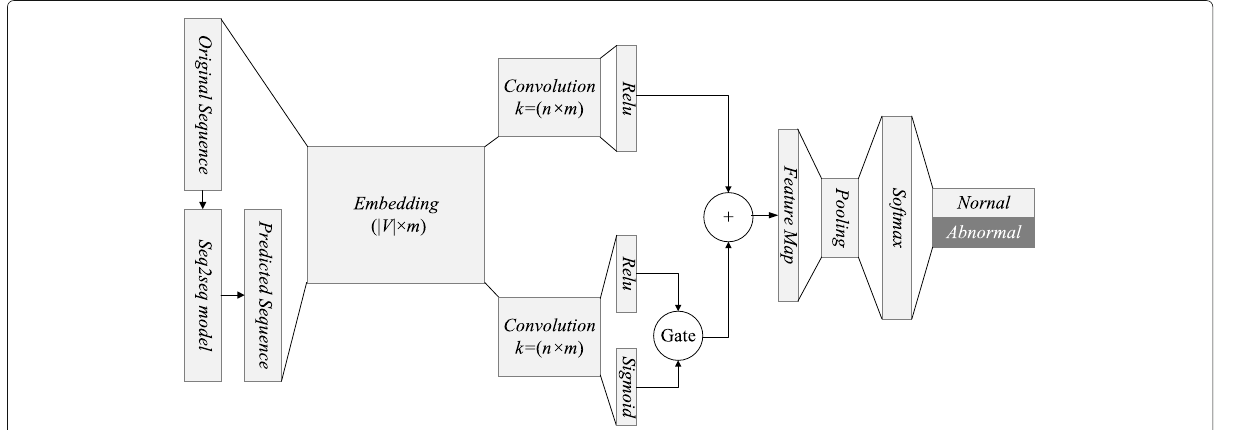
Fig. 5 The structure of gated CNN classification model for anomaly intrusion detection